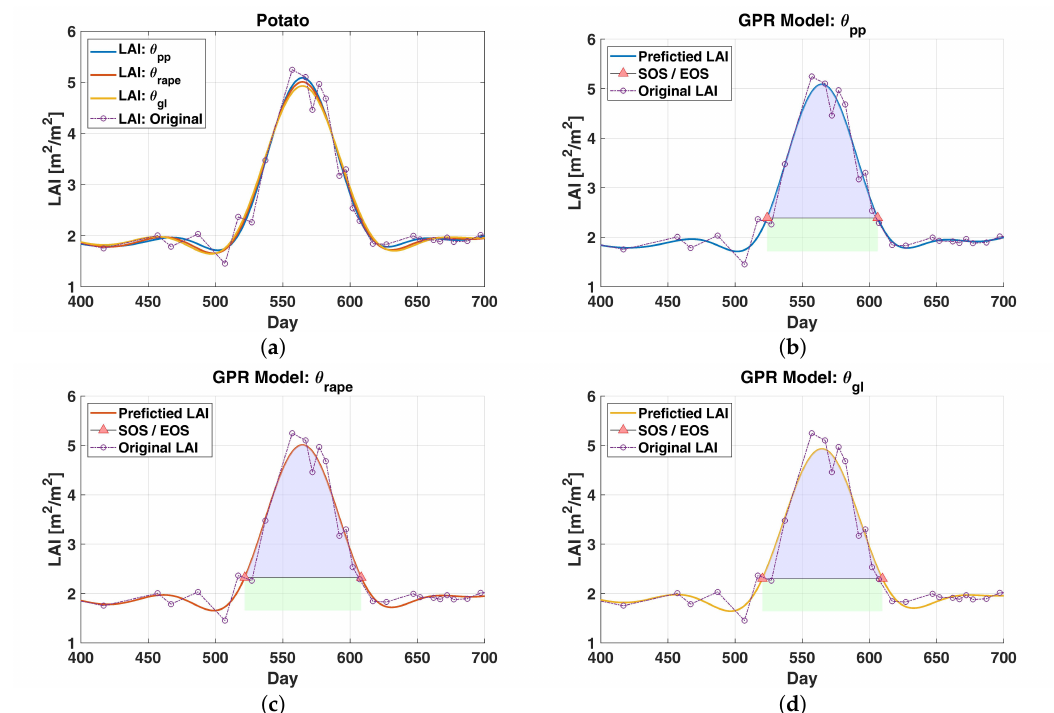
Figure 3. Modeling LAI time series of potato by using different GPR parametrizations ( θ pp , θ corn , θ gl ) (Figure 3a) and automatic identification of some seasonal patterns (Figure 3b, 3c and 3d). The green and blue colors represent the area under the curve between SOS and EOS. For reasons of clarity the associated GPR uncertainties are not displayed. Counting of days starts from 1 January 2016. Table 7. Automatic identification of some seasonal patterns computed in DATimeS by using the reconstructed LAI curves shown in Figures 2 and 3. Units: days for SOS, EOS, LOS, DOM; [ m 2 /m 2 ] for max value and amplitude; [ m 2 /m 2 d ] for blue and green area. Wheat